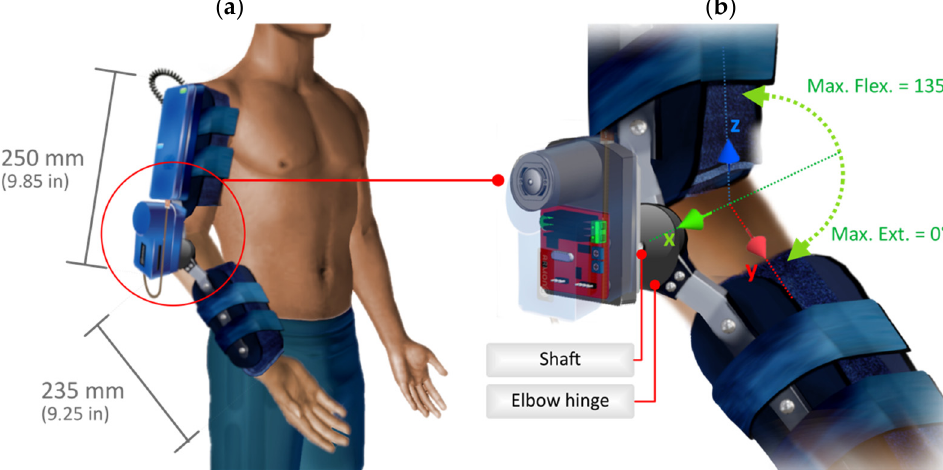
Figure 3. Attachment of the exoskeleton prototype to the upper limb. Part ( a ) shows the location of the exoskeleton and its size. Part ( b ) shows the actuation system in